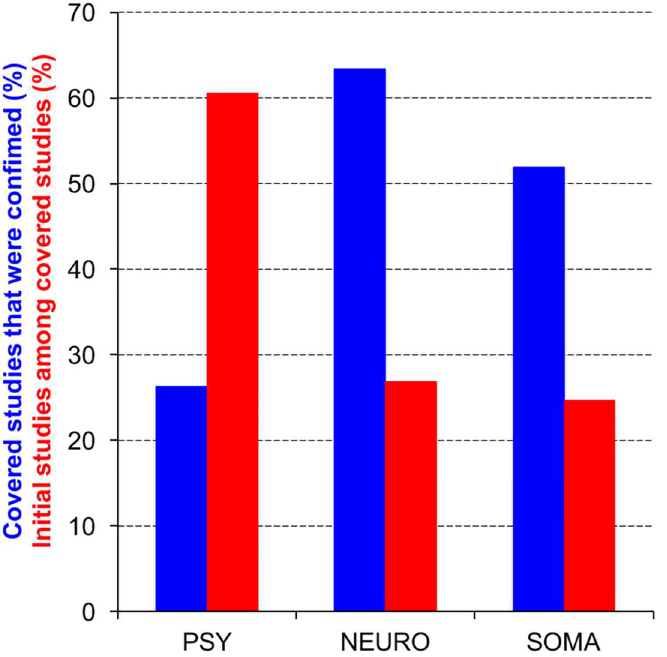
Fig 3. Replication validity of primary studies reported by newspapers in three biomedical domains. The blue bars show the percentage of primary studies coveredby newspapers whose main finding was consistent with the correspondingmeta-analysis. The red bars show the percentageof initial findingsamong primary studies echoed by newspapers and related to four psychiatric disorders(PSY), four neurological diseases(NEURO) and four somatic diseases(SOMA). Raw data are given in SupportingInformation (S2 Text).